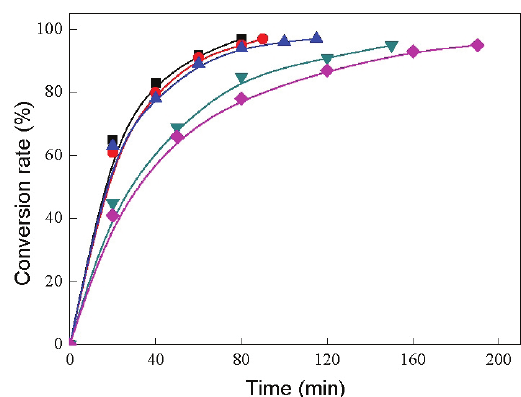
Fig. 1 – Catalysis of CPC with the immobilized CCA in dif- ferent buffers. Water (square); phosphate (circle); Tris-HCl (up-triangle); bicarbonate (down-triangle); acetate (diamond).